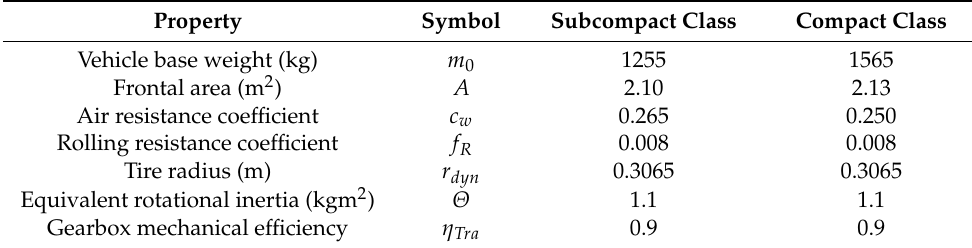
Table 2. Vehicle parameters of the two investigated vehicle